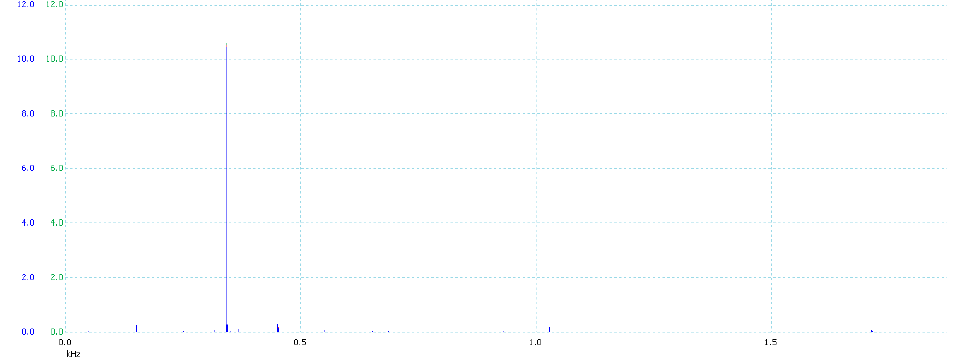
Figure 21. AFPMA no load three-phase line-neutral voltages tested at m N = 5000 RPM.